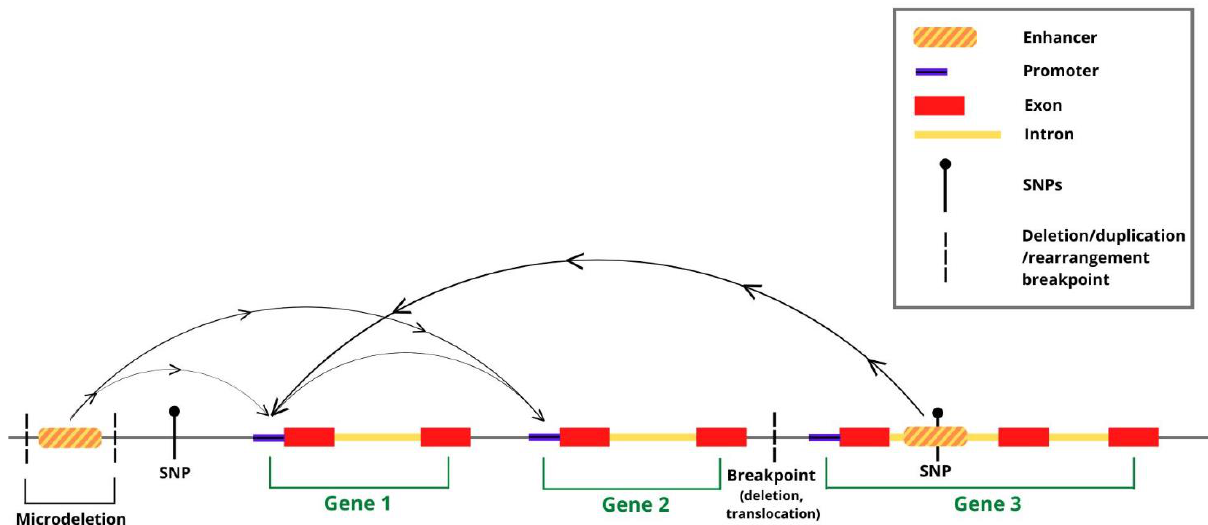
Figure 1. Long-range interactions in chromatin (arches) connect distant putative enhancers to gene promoters. Putative enhancers are shown, overlapping DNA sequence variants (SNPs; CNVs, such as deletions/duplications/rearrangements) associated to NDD. Interactions provide a way to associate variant-containing enhancers to distant gene promoters (arrows on the arches-connections), which they may regulate/misregulate in disease. Putative enhancers connected to more than one promoter, as well as promoter-promoter interactions, have also been detected (see text).